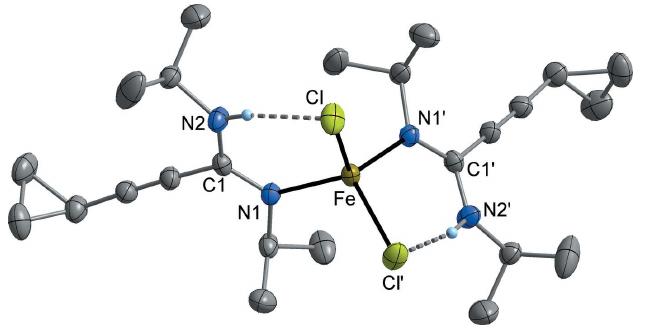
Figure 3 Molecular structure of 4 in the crystal. Displacement ellipsoids are drawn at the 50% level, C-bound H atoms omitted for clarity. Symmetry code: ( 0 ) 1 (cid:3) x , 1 (cid:3) y , z .